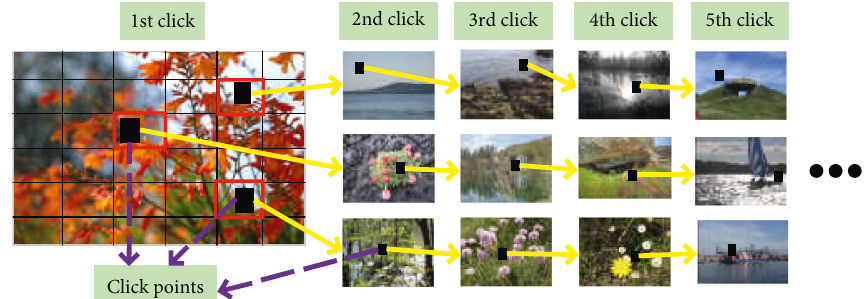
Figure 2: Selection of a sequence of points on a picture set in the CCPGP system